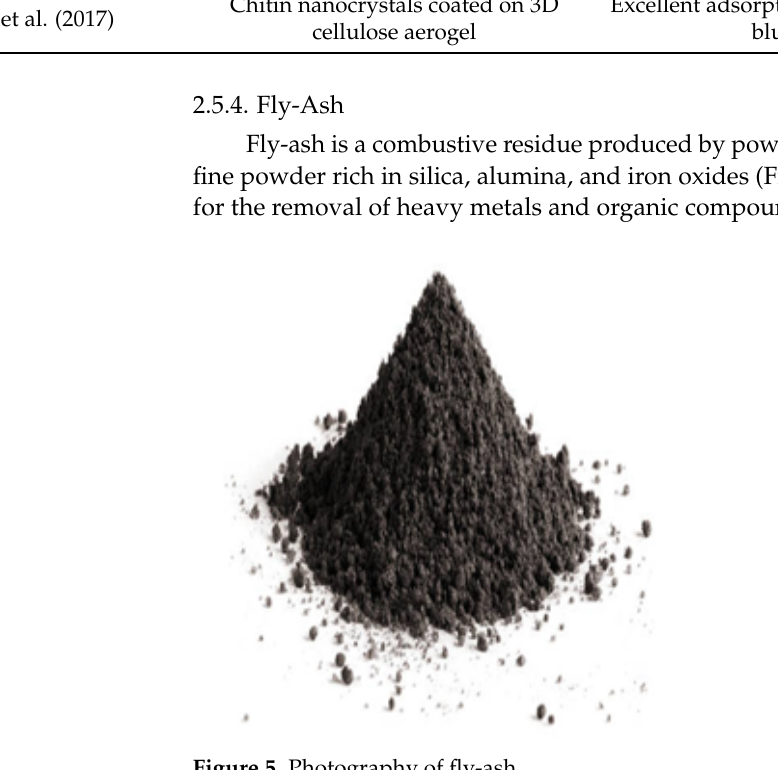
Figure 5. Photography of